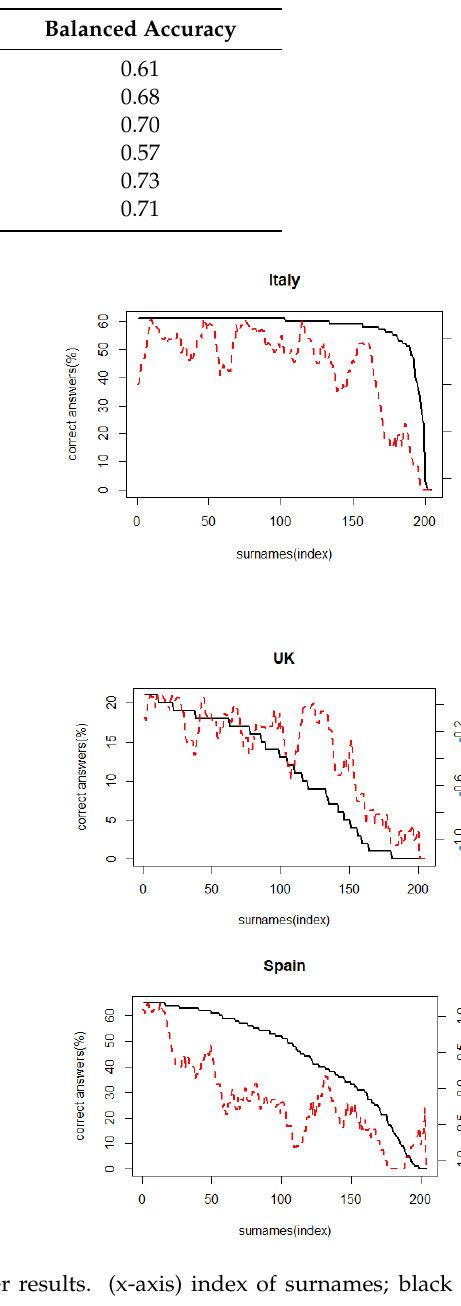
Table 3. Prediction results with Mturk dataset.